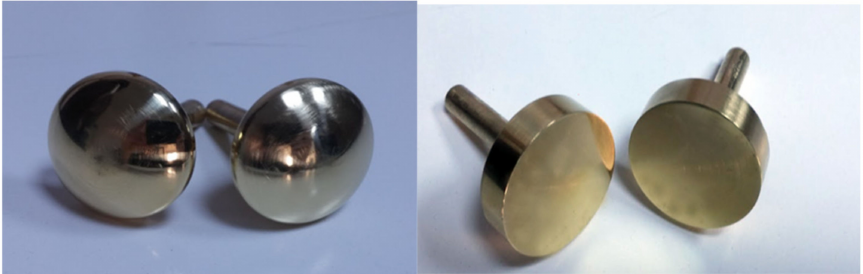
Figure 1. VDE ( left ) and disc ( right ) electrodes used in